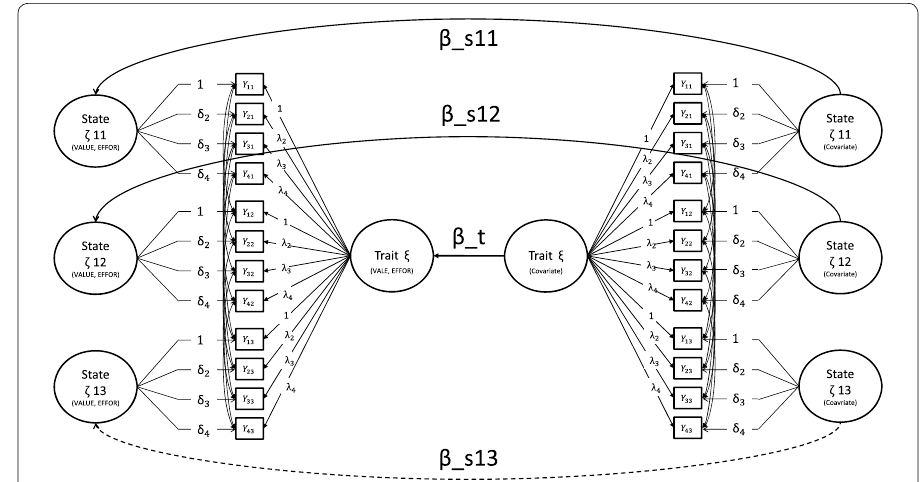
Fig. 2 STMS model (butterfly model) with test motivation and psychological predictors. VALUE Subjective = test value dimension of the test motivation construct. EFFOR Effort dimension of the test motivation = construct. 11, 12, 13 grade 11, grade 12, grade 13. The state-like components overlap only at grade 11 = and 12 with the test motivation’s state-like component. For this reason the association β _s13 (states at grade 13) is depicted as dashed line indicating that this association is not investigated in the present study. β _t (trait), β _s11 (states at grade 11), and β _s12 (states at grade 12) indicate the associations of interest. The correlated uniqueness approach (item/method-specific correlations over time) is indicated by vertical curved (unlabelled)